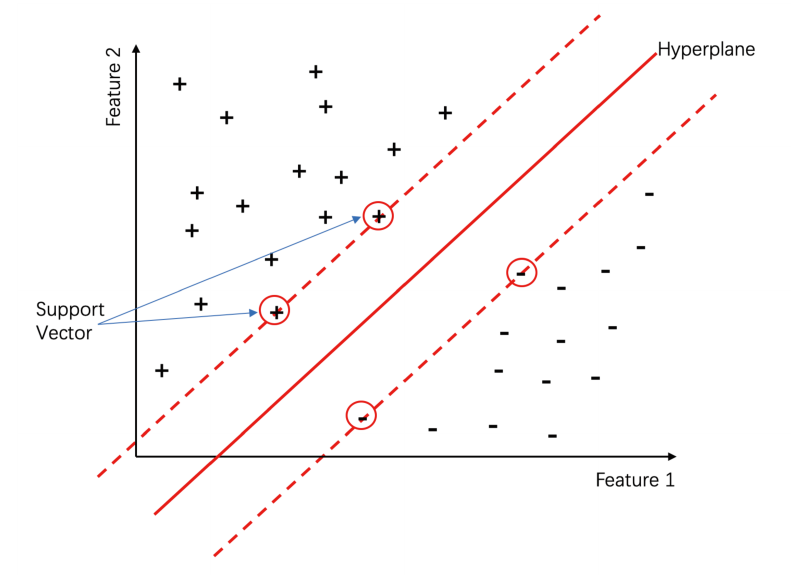
Figure 3. A simple illustration of SVM; + and - represent the sample